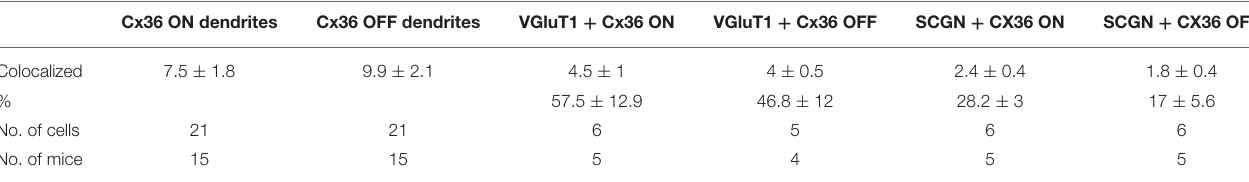
TABLE 2 | Statistics for Cx36-containing gap junctions on the dendrites of A8 cells and the colocalization with bipolar cell